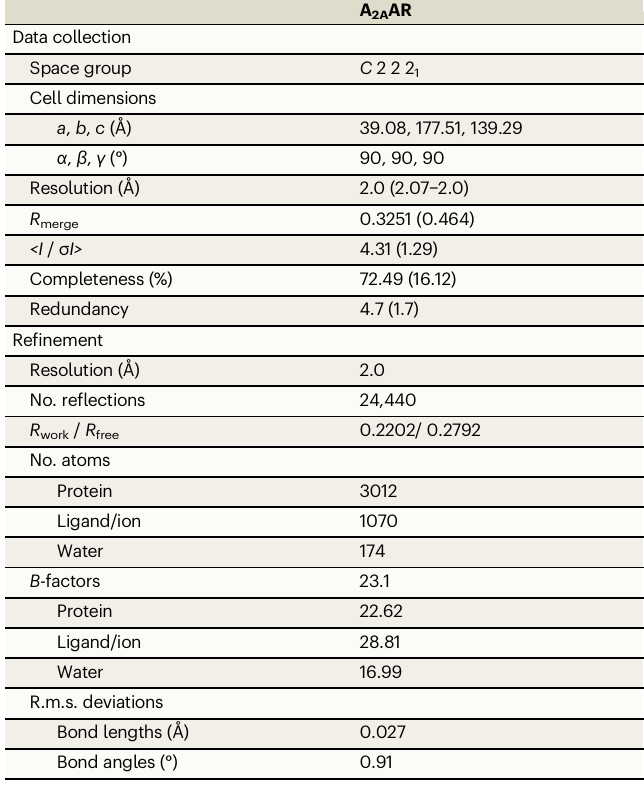
Table 2 | MicroED structure of A 2A AR determined from microcrystals in LCP